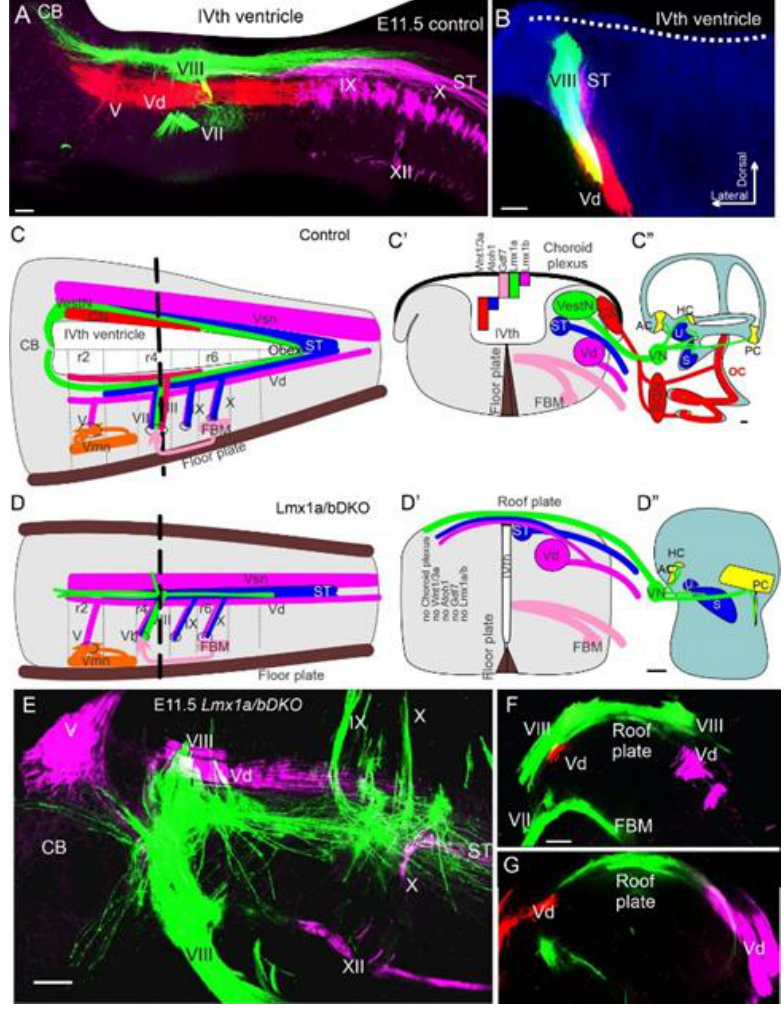
Figure 7. Central projections of the ear depending on the brainstem. Vestibular neurons project dorsally in the hindbrain in control and Lmx1a/b DKO mice (VIII; A,B,C , D , E ). However, in Lmx1a/b DKO mice, central cochlear projections never develop as they do in controls ( C ”, D ”). In addition, in Lmx1a/b DKO mice, vestibular projections interconnect across the roof plate ( D , D ’, E , F , G ), whereas vestibular fibers are normally separated by the choroid plexus ( A , B , C , C’ ). In addition to the loss of the cochlea and spiral ganglion neurons, the cochlear nucleus does not form in Lmx1a/b DKO mice ( C’ , C” ). Furthermore, in Lmx1a/b DKO mice, Atoh1, Gdf7 , and Wnt1/3a expressions are absent ( C ’, D’ ). As a reference we have provide coronal section of control ( B ) and Lmx1/a DKO mice ( F , G ). Bar 100 µ m. CB, cerebellum; FBM, facial branchial motoneurons; V–XII, various cranial neurons. The bar is 100 µ m. Modified after